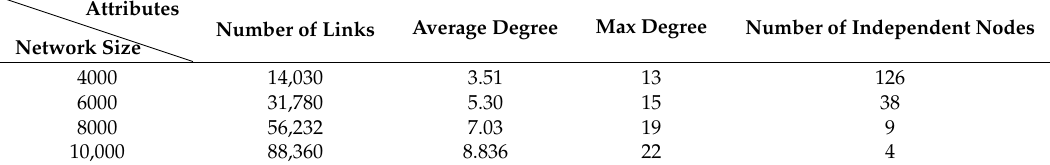
Table 2. Basic attributes of